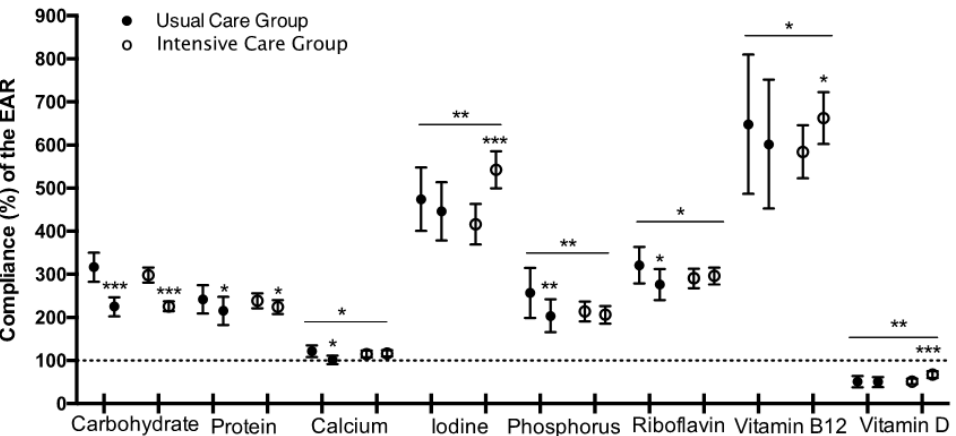
Figure 1. Change in the compliance (%) of the dietary recommendations (EAR) after lifestyle intervention in children with abdominal obesity. * p -value < 0.05, ** p -value < 0.01 and *** p -value < 0.001.